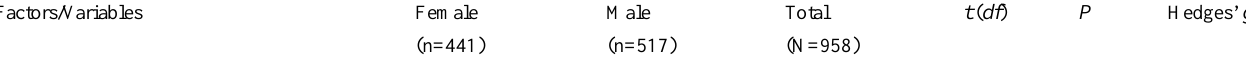
Table 5. Gender differences of weighted factor sum scores for the personal disposition of being well-informed influencing Internet health information search behavior on an aggregate as well as on a basis